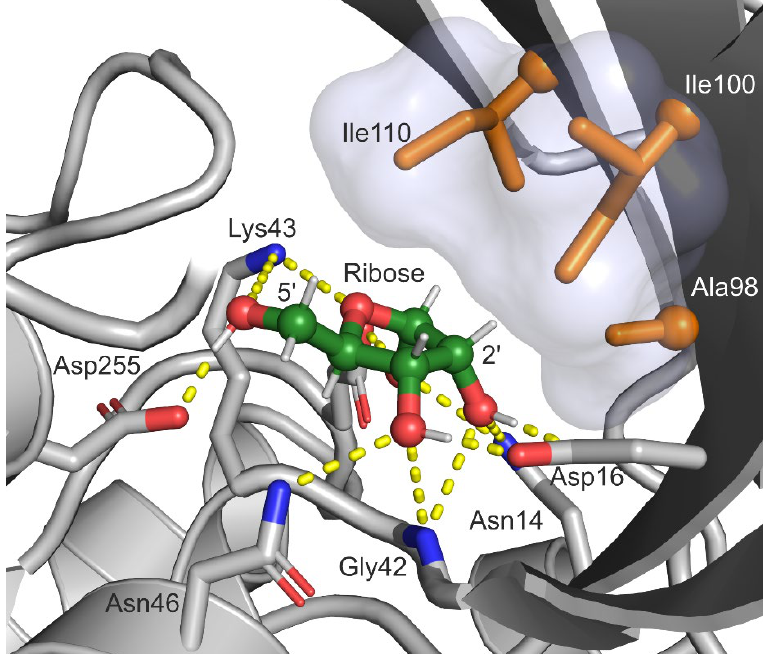
Figure 3. The position of ribose in the active site of Eco RK (PDB 1RKD). The semi-transparent surface represents the hydrophobic interface in the lid domain, formed by Ala98, Ile100 and Ile110. Residues 248–251 and 285–295 are hidden. Carbon atoms of ribose are colored green, carbon atoms of residues Ala98, Ile100 and Ile110—orange, oxygen atoms—red, nitrogen atoms—blue. Yellow dashed lines represent polar contacts Visualization was performed in PyMOL 2.0 (Schrödinger, LLC).